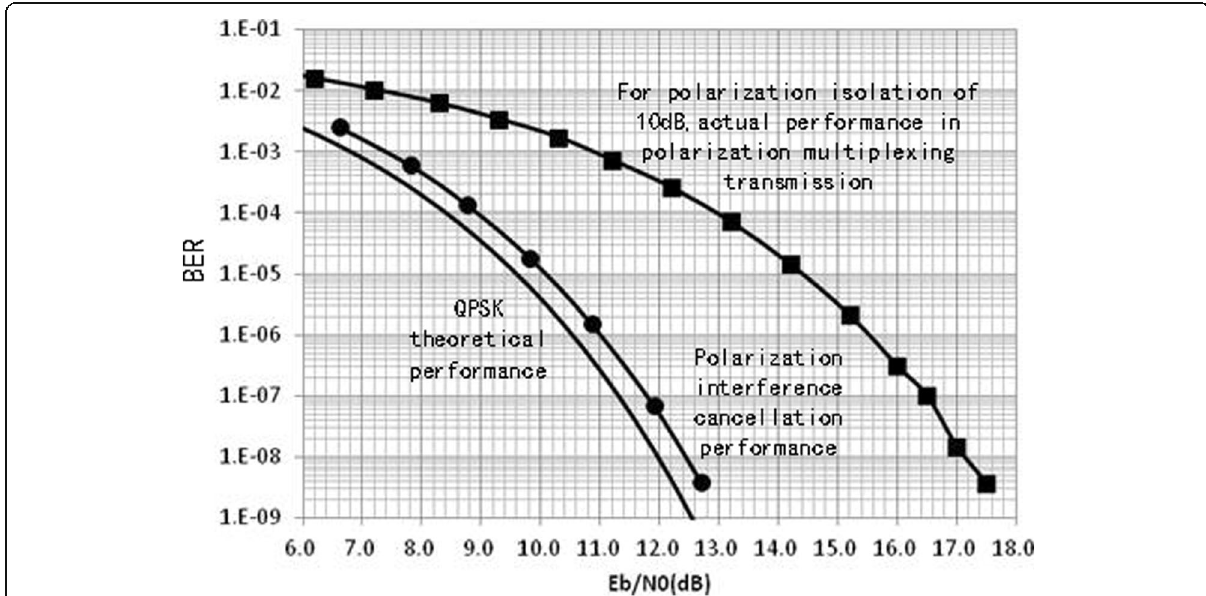
Fig. 14 Test situations before and after QPSK signal filtering. This figure shows a graph of test situations before and after QPSK signal